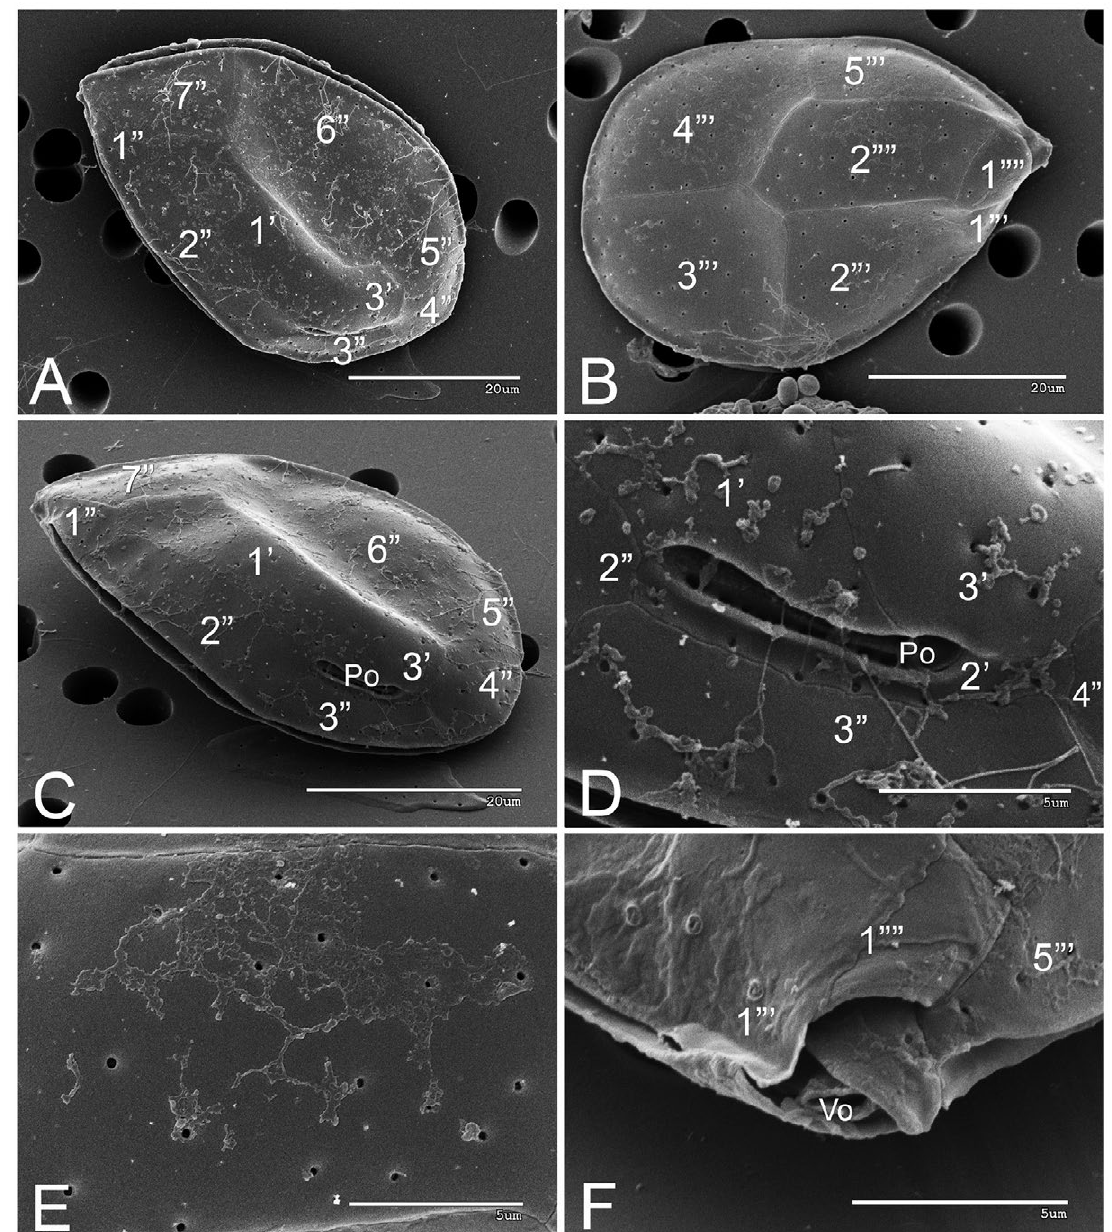
Fig. 4. – Thecal morphology of Ostreopsis cf. ovata (strain 1G) viewed with scanning electron microscopy. A, apical (epithecal) view; B, antapical (hypothecal) view; C, anterior-dorsal-left-side view; D, the apical pore plate and adjacent epithecal plates in left-side view; E, a fragment of the 1 plate with irregularly scattered trichocyst pores; F, a fragment of the hypotheca and the sulcal area. Plate labels: 1 ′ -3 ′ , the apical plates; 1 ″ -7 ″ the precingular plates; 1 ′′′ -5 ′′′ , the postcingular plates; 1 ′′′′ and 2 ′′′′ , the antapical plates; Po, the apical pore plate; Vo, the ventral opening. The plates are named according to Hoppenrath et al. (2014). Scale bars: 20 µm in A-C, 5 µm in